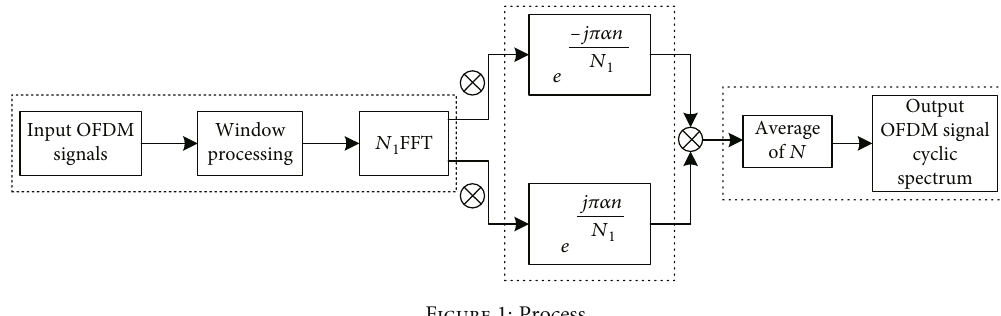
Figure 1: Process.